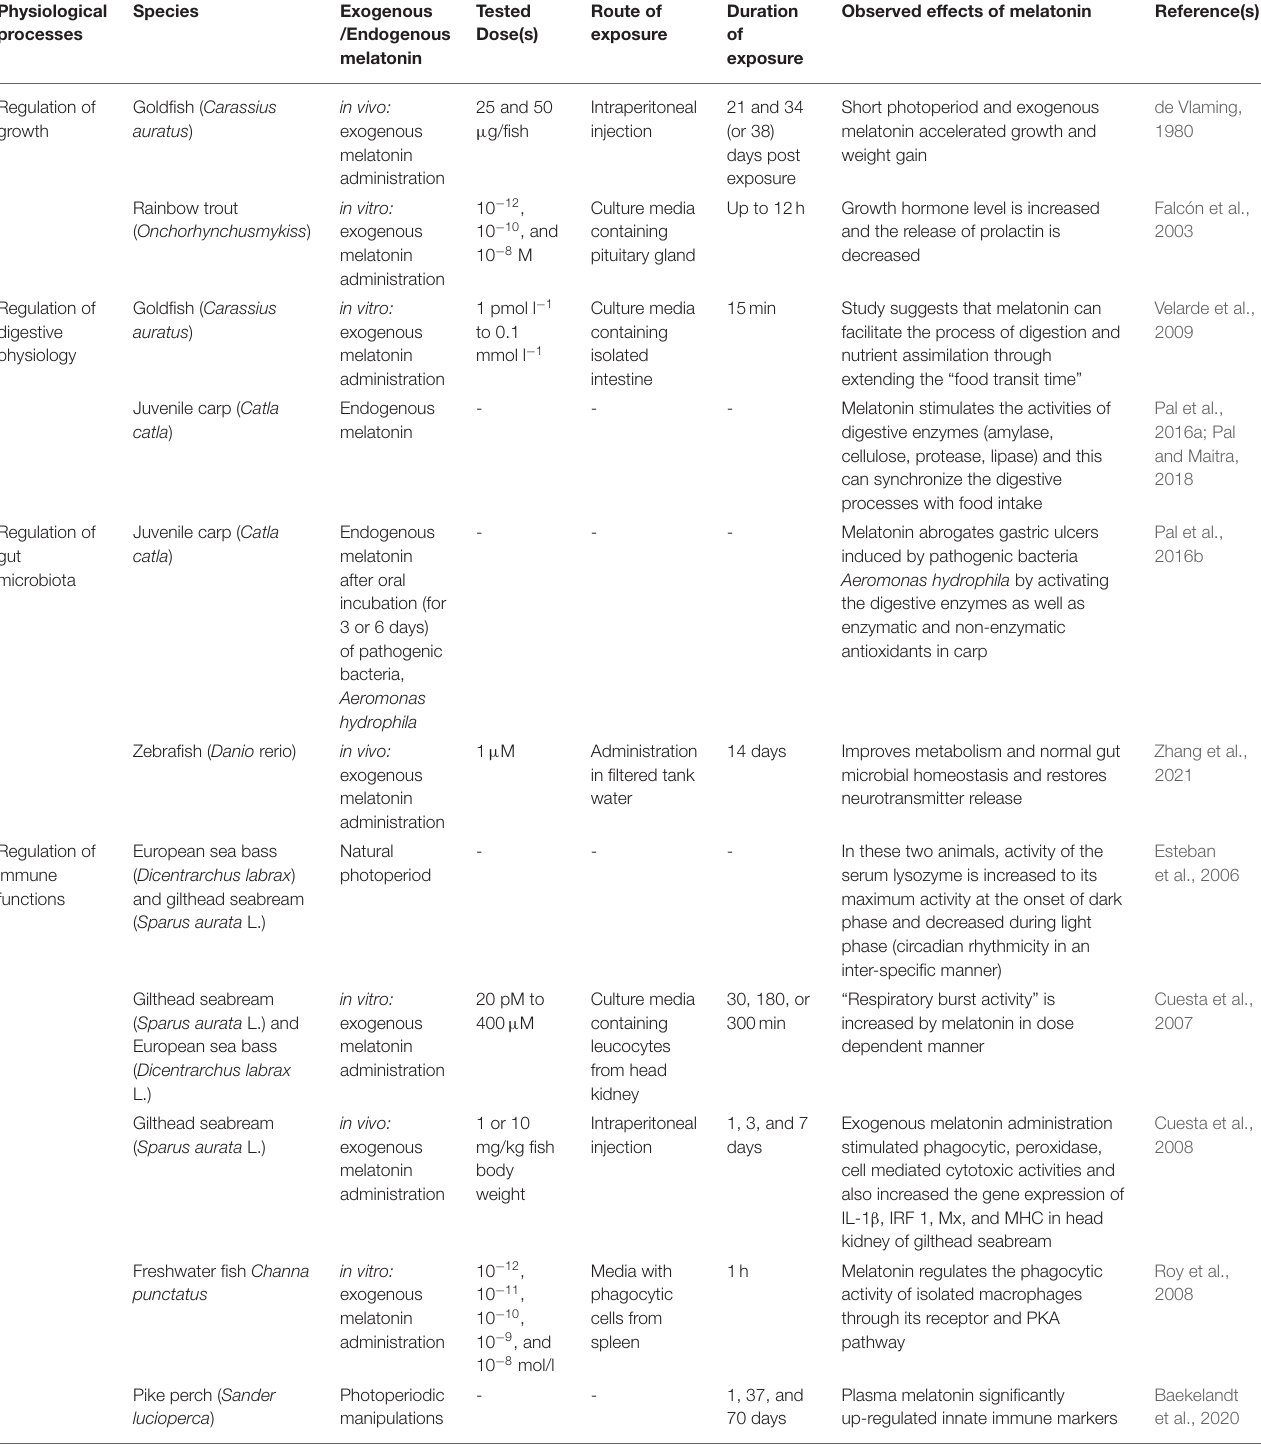
TABLE 2 | Some critical findings on melatonin in the regulation of various physiological functions of both freshwater and marinewater fish at a glance: why melatonin can be incorporated in fish diet in sustainable aquaculture? Physiological